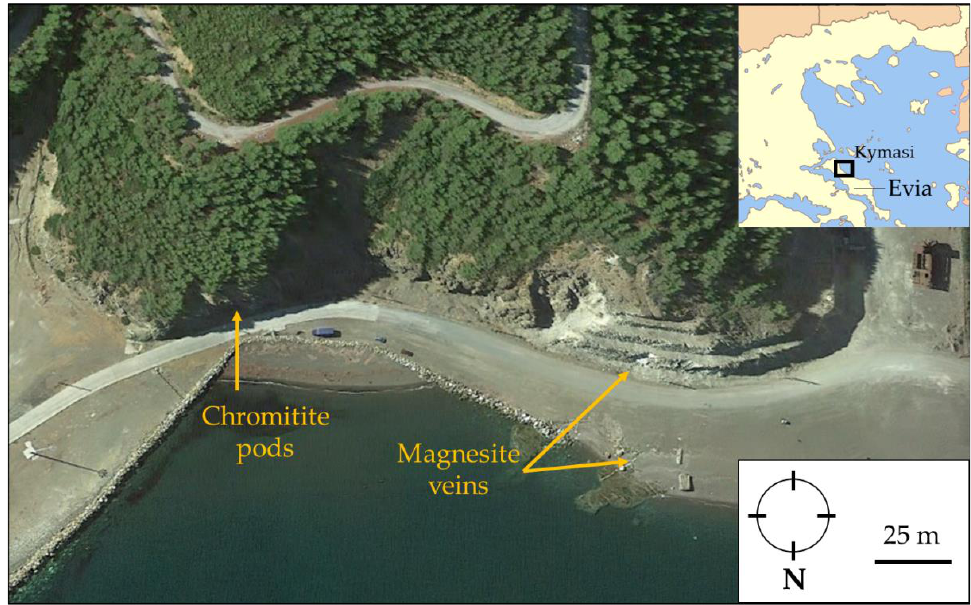
Figure 2. Sampling position (Google Earth ® ) of chromitite pods, magnesite veins, and their host rock.